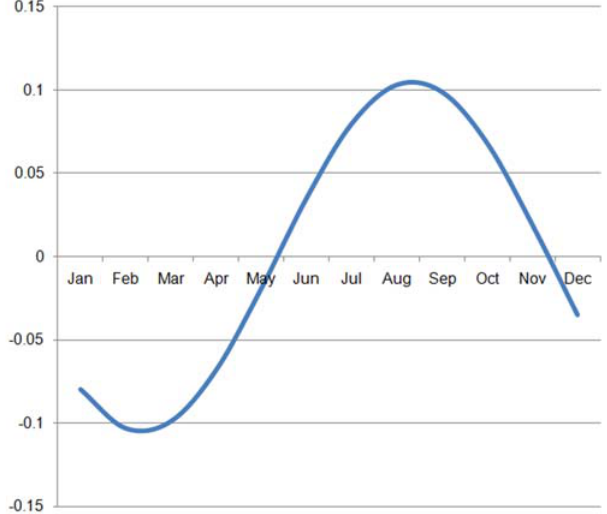
Figure 1. The modelled seasonal change in average flock gait score.